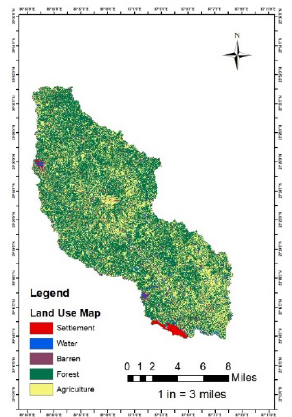
Figure 3. Land use map of the study area